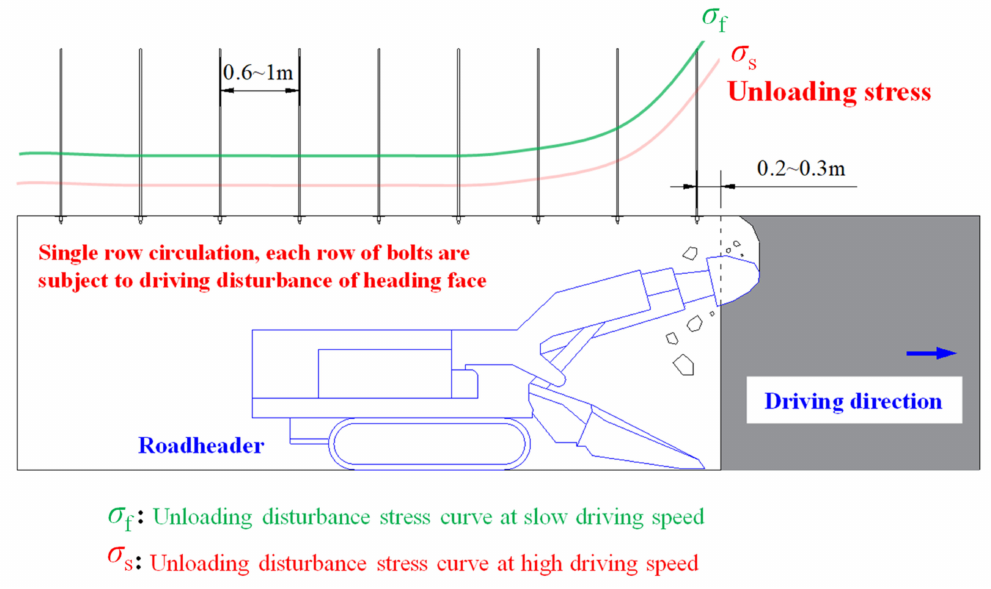
Figure 12. The disturbance influence of unloading stress on the roof strata under different driving